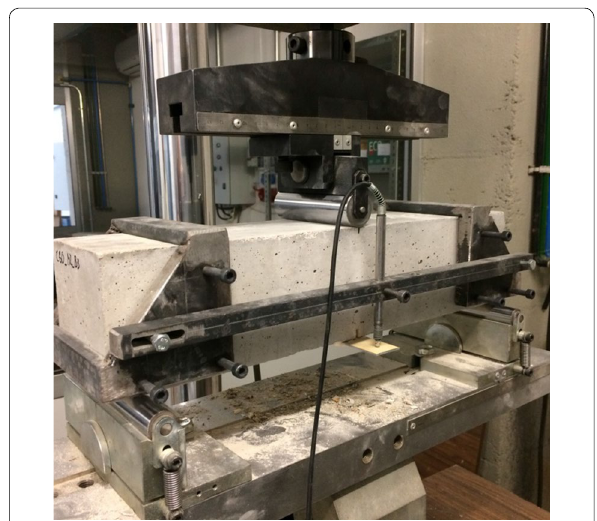
Fig. 5 Three‑point bending test of a notched specimen according to the RILEM work‑of‑fracture